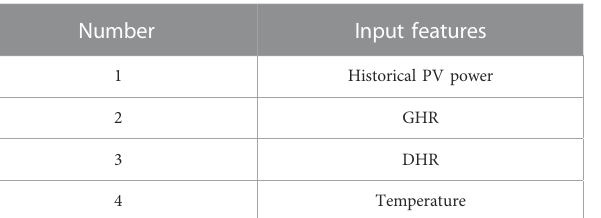
TABLE 2 Proposed model ’ s input